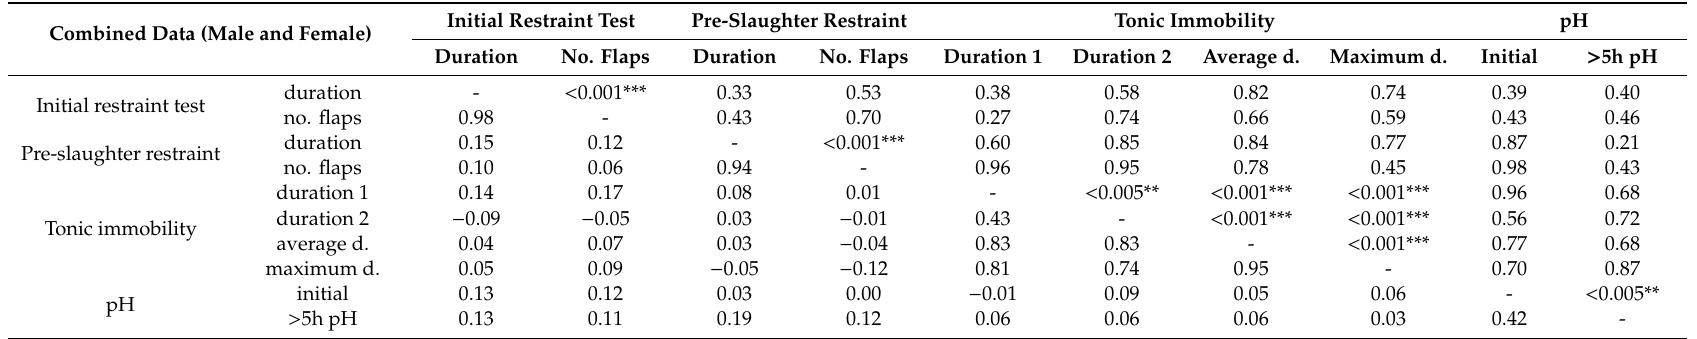
Table 3. Partial Spearman’s correlations (controlling for sex) for tonic immobility, inverted restraint and muscle pH in the F 13 verification cohort. Numbers above the diagonal show the p -value significance of each pairwise correlation (* p < 0.05, ** p < 0.01, *** p < 0.001), whilst numbers below the diagonal are the Rho correlation coe ffi